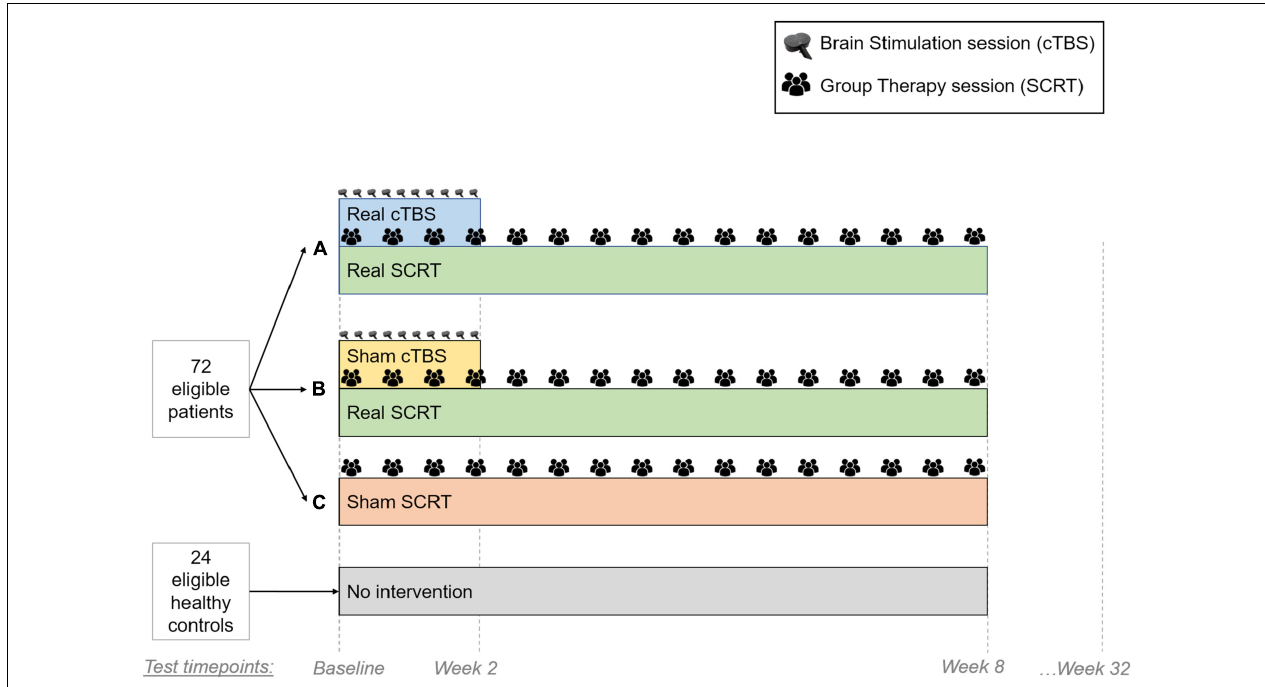
FIGURE 1 | Study Setup. We will randomize 72 schizophrenia patients in three different groups (24 patients per group). Group A will receive real cTBS and real SCRT. Group B will receive sham cTBS and real SCRT. Group C will receive no cTBS and sham SCRT. Both sham treatments are inactive interventions that mimic